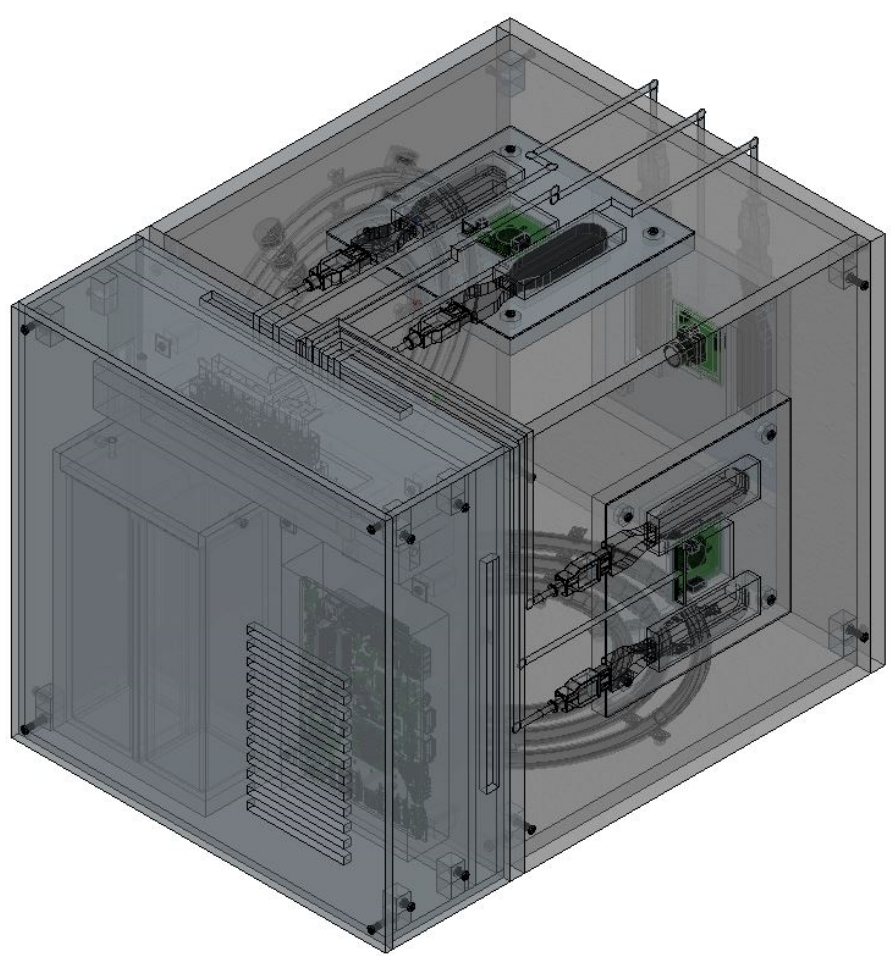
Figure 4. Three-dimensional (3D) perspective view of a PIVG.